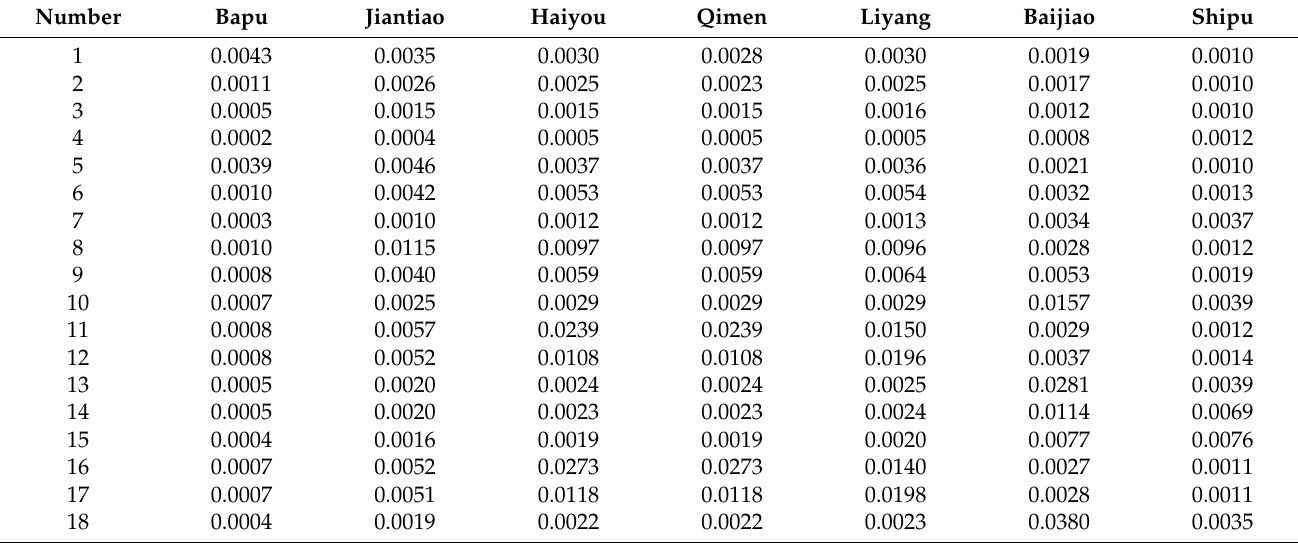
Table 4. COD Mn concentration field (mg/L).